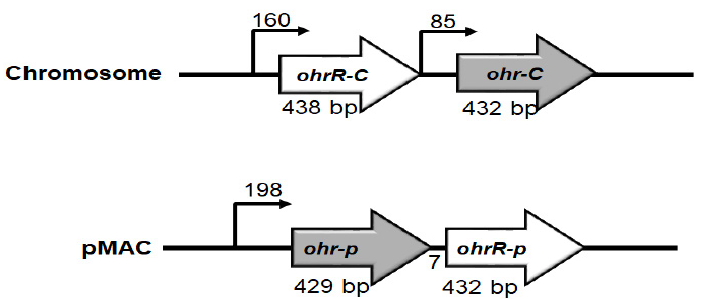
Figure 1. Genetic organization of ohr-ohrR genes on chromosomal DNA and pMAC. Numbers above bent arrows indicate the distance in base pairs between two genes.